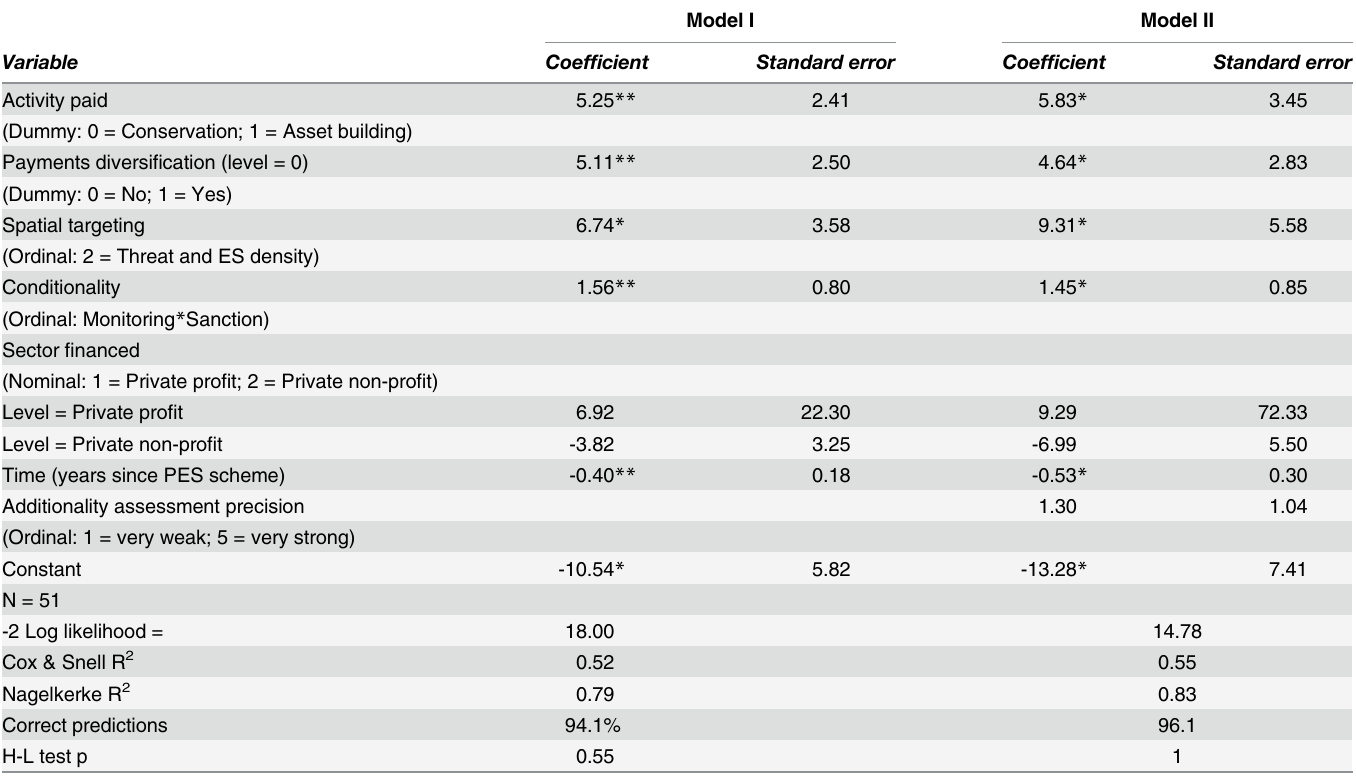
Table 3. Binary logistic regression model predicting the degree of PES environmental